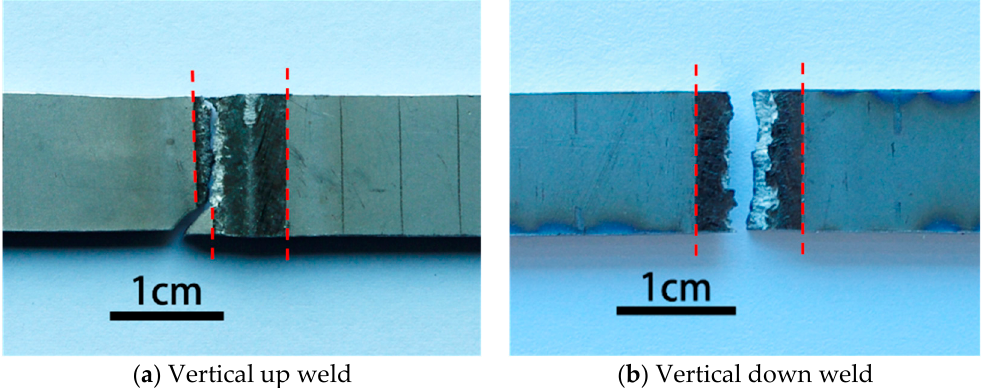
Figure 11. Fractured specimens of ( a ) vertical up weld; and ( b ) vertical down weld with higher heat input (2200 W, 0.5 m/min).